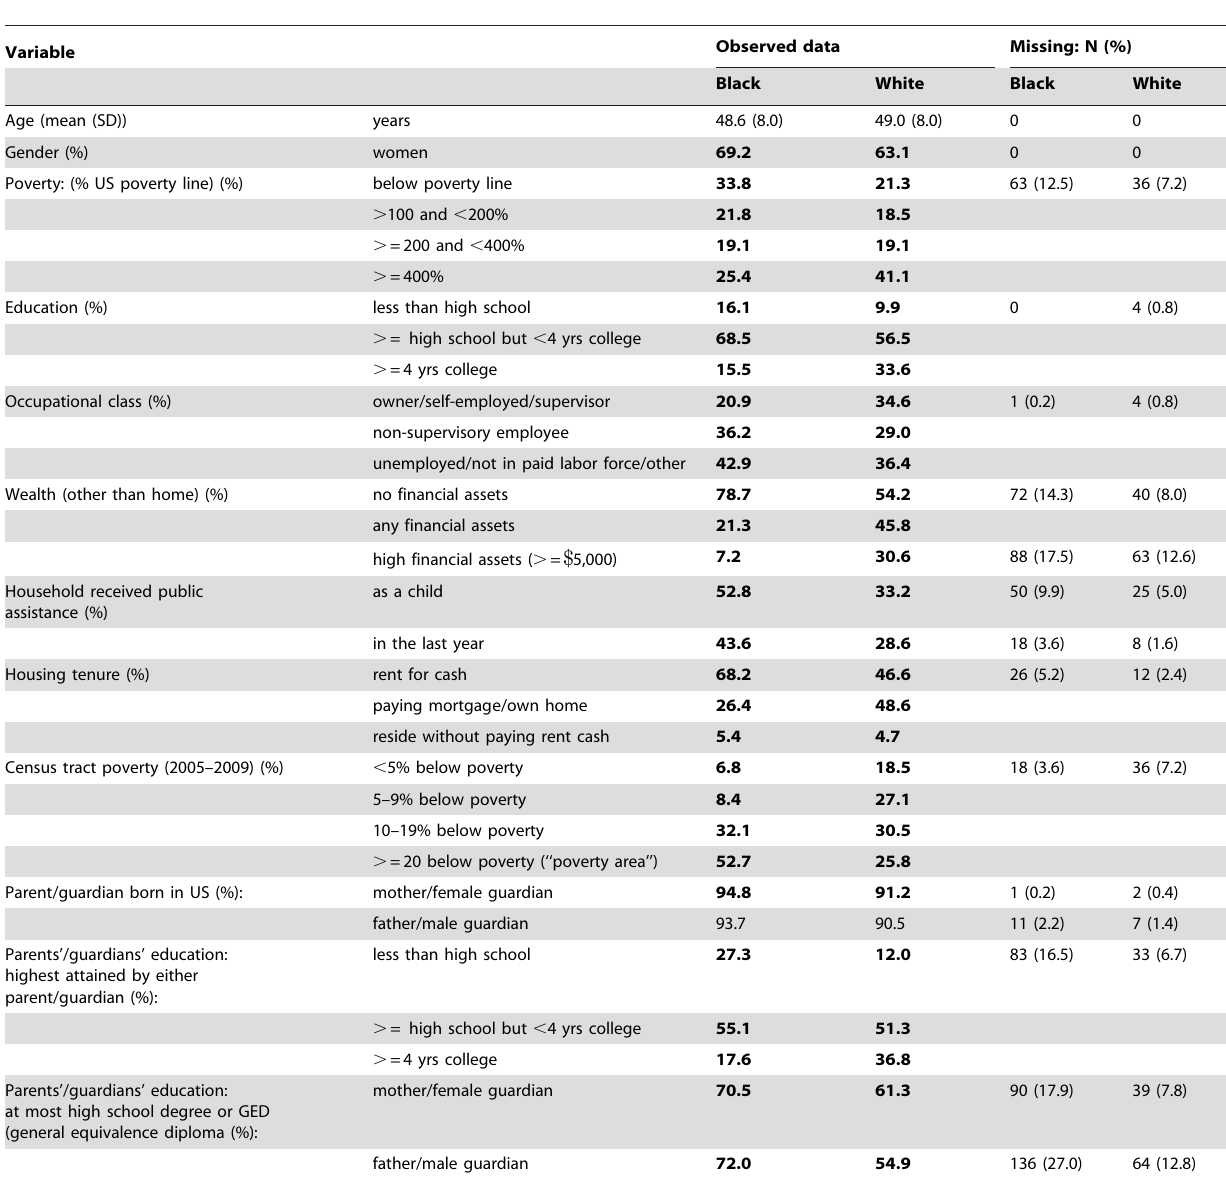
Table 1. My Body My Story study participants’ sociodemographic and socioeconomic characteristics: 504 black and 501 white community health center members, all US-born, non-Hispanic, ages 35–64 (Boston, MA,